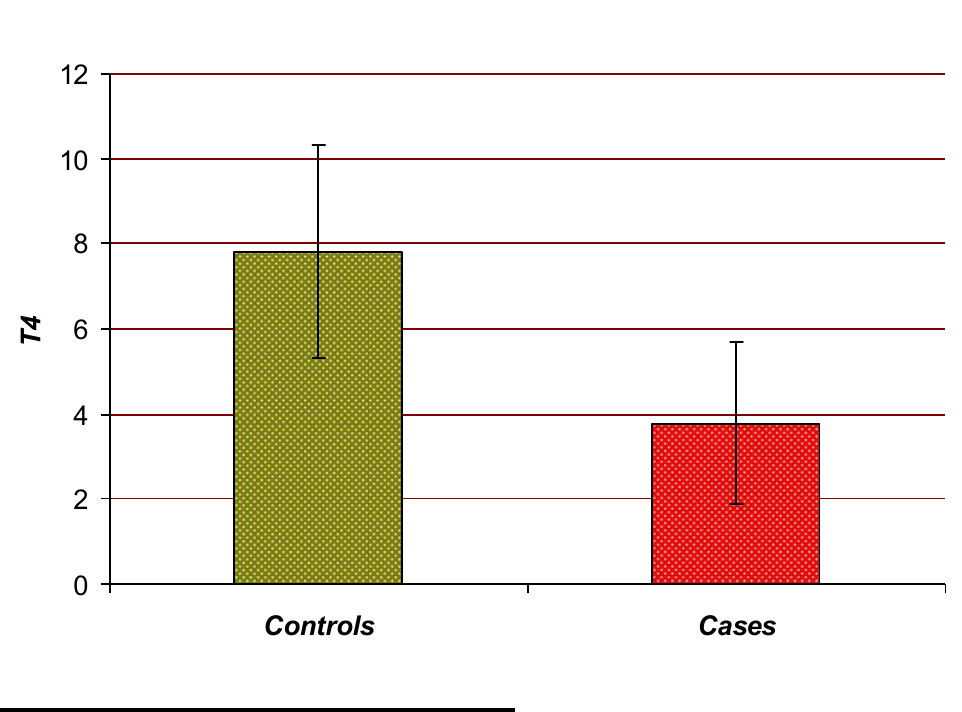
Figure 4B: Comparison of levels of T4 between controls and